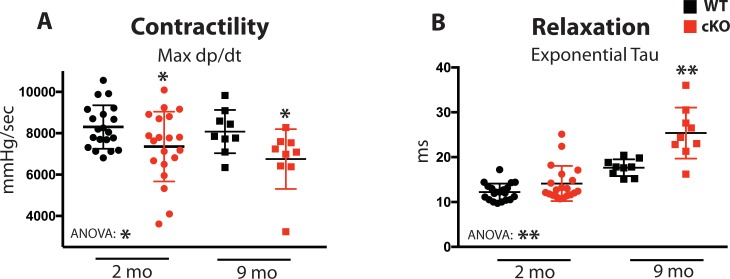
Fam20C regulates cardiac contractility and relaxation in vivo.Hemodynamic assessment of contraction and relaxation (n = 9–20). (A) Assessment of maximum pressure difference over time (dP/dt). (B) Assessment of the isovolumetric relaxation constant tau. Data are represented as the mean ±SEM. *p < 0.05; **p < 0.01, by Student’s t test or ANOVA (when indicated) for WT v. cKO.